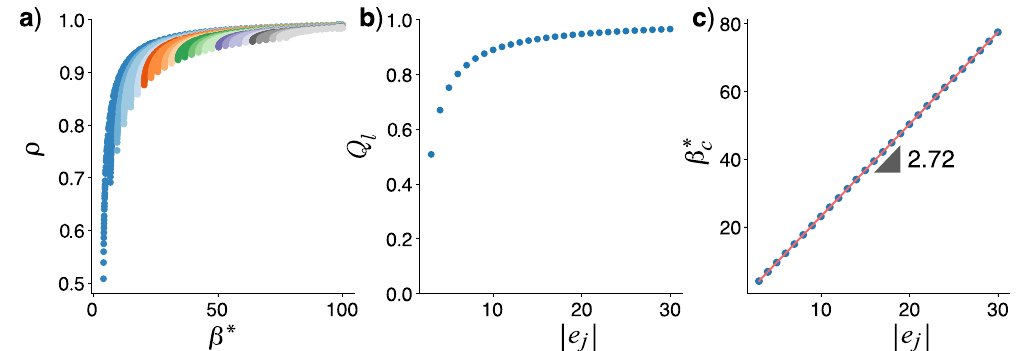
Fig. 4 Numerical results for the social contagion dynamics on uniform hypergraphs. a The feasible stable solution as a function of the scaled spreading rate β * for different values of cardinality (color-coded), in the range from ∣ e j ∣ = 3 in blue, to ∣ e j ∣ = 30 in light gray. b The fi rst non-zero positive value of the stable solution, Q l , as a function of the cardinality. c Depicts the behavior of β * at the tipping point, β (cid:2) c , as a function of the cardinality, revealing a linear behavior.